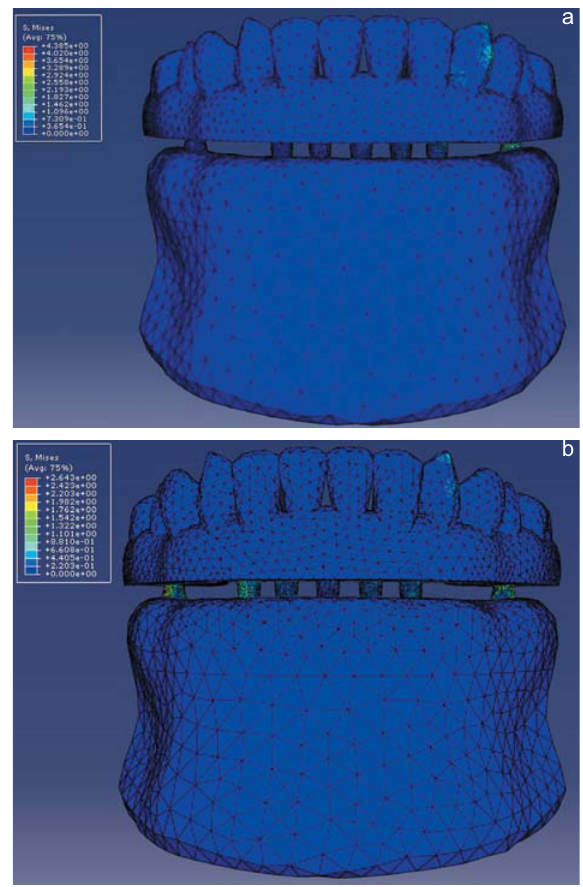
Figure 2- Distribution of the equivalent stress generated by disocclusion in canine guide occlusion (CGO) (a) and bilateral balanced occlusion (BBO) (b) on the complete